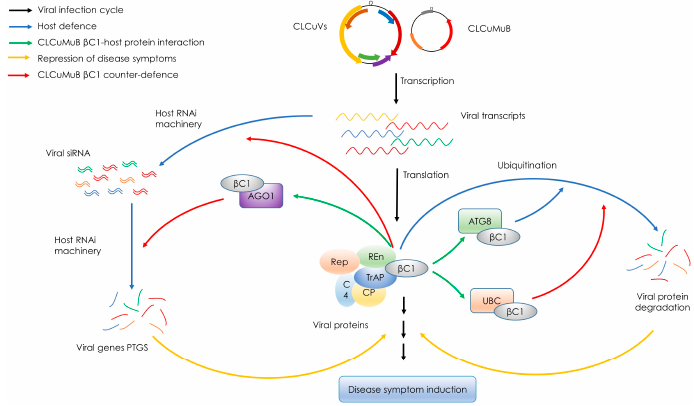
Figure 2. A working model for the role of Cotton leaf curl Multan betasatellite (CLCuMuB) β C1 protein in disease progression and suppression of host defense. Black arrows indicate un-interrupted virus infection cycle, blue arrows represent host defense mechanisms, green arrows represent β C1 interaction with host proteins, orange arrows represent the repression of leaf curl disease symptoms and red arrows represent the counter-defense mechanisms triggered by CLCuMuB β C1. Begomoviruses associated with cotton leaf curl disease (CLCuVs), along with CLCuMuB, produce transcripts of virus genes and β C1 , respectively. In an un-interrupted disease infection cycle, these transcripts are translated in respective proteins, that in-turn interact with several cellular proteins that induces typical leaf curl disease symptoms. But usually the viral transcripts are targeted by the host’s RNA interference (RNAi) machinery that subsequently degrades the viral gene transcripts in a process called post-transcriptional gene silencing (PTGS) and interferes with disease progression and symptom development. CLCuMuB β C1 has been reported to interact with host protein AGO1 and acts as a strong suppressor of PTGS; this assisting the helper virus in normal disease progression and symptom development. CLCuMuB β C1 can also suppress systemic gene silencing, resulting in reduced levels of viral siRNAs. Viral proteins and β C1 are also targeted by cellular autophagy machinery that degrades these proteins through a cellular mechanism called ubiquitination. Host protein ATG8 has been reported to interact with CLCuMuB β C1 in an attempt to induce autophagy. CLCuMuB β C1 has also been reported to interact with a cellular protein UBC, and this interaction interferes with the ubiquitination, leading the infected cells towards disease progression and symptom development. It must be noted that only the functional roles of CLCuMuB β C1, and among those only the ones that are experimentally confirmed, have been shown here; the functions and β C1-host protein interaction may vary for different species of